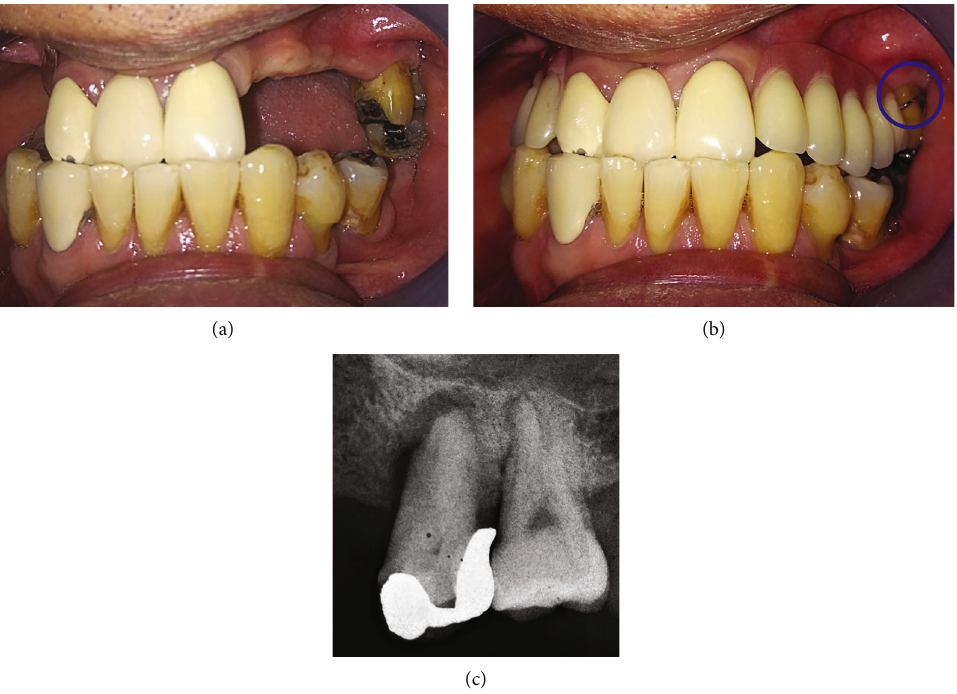
Figure 1: Initial condition. (a) Intraoral condition of gingival region tooth #26 showed recession without visible abscess. (b) Intraoral condition when the patient wore denture with a single clasp on tooth #26 (shown in blue circle). (c) Initial radiograph condition. Overhanging restoration on the distal part of the crown. Radiolucency surrounded the mesial and apical parts of the roots. Table 1: Periodontal Chart of Tooth 26 and